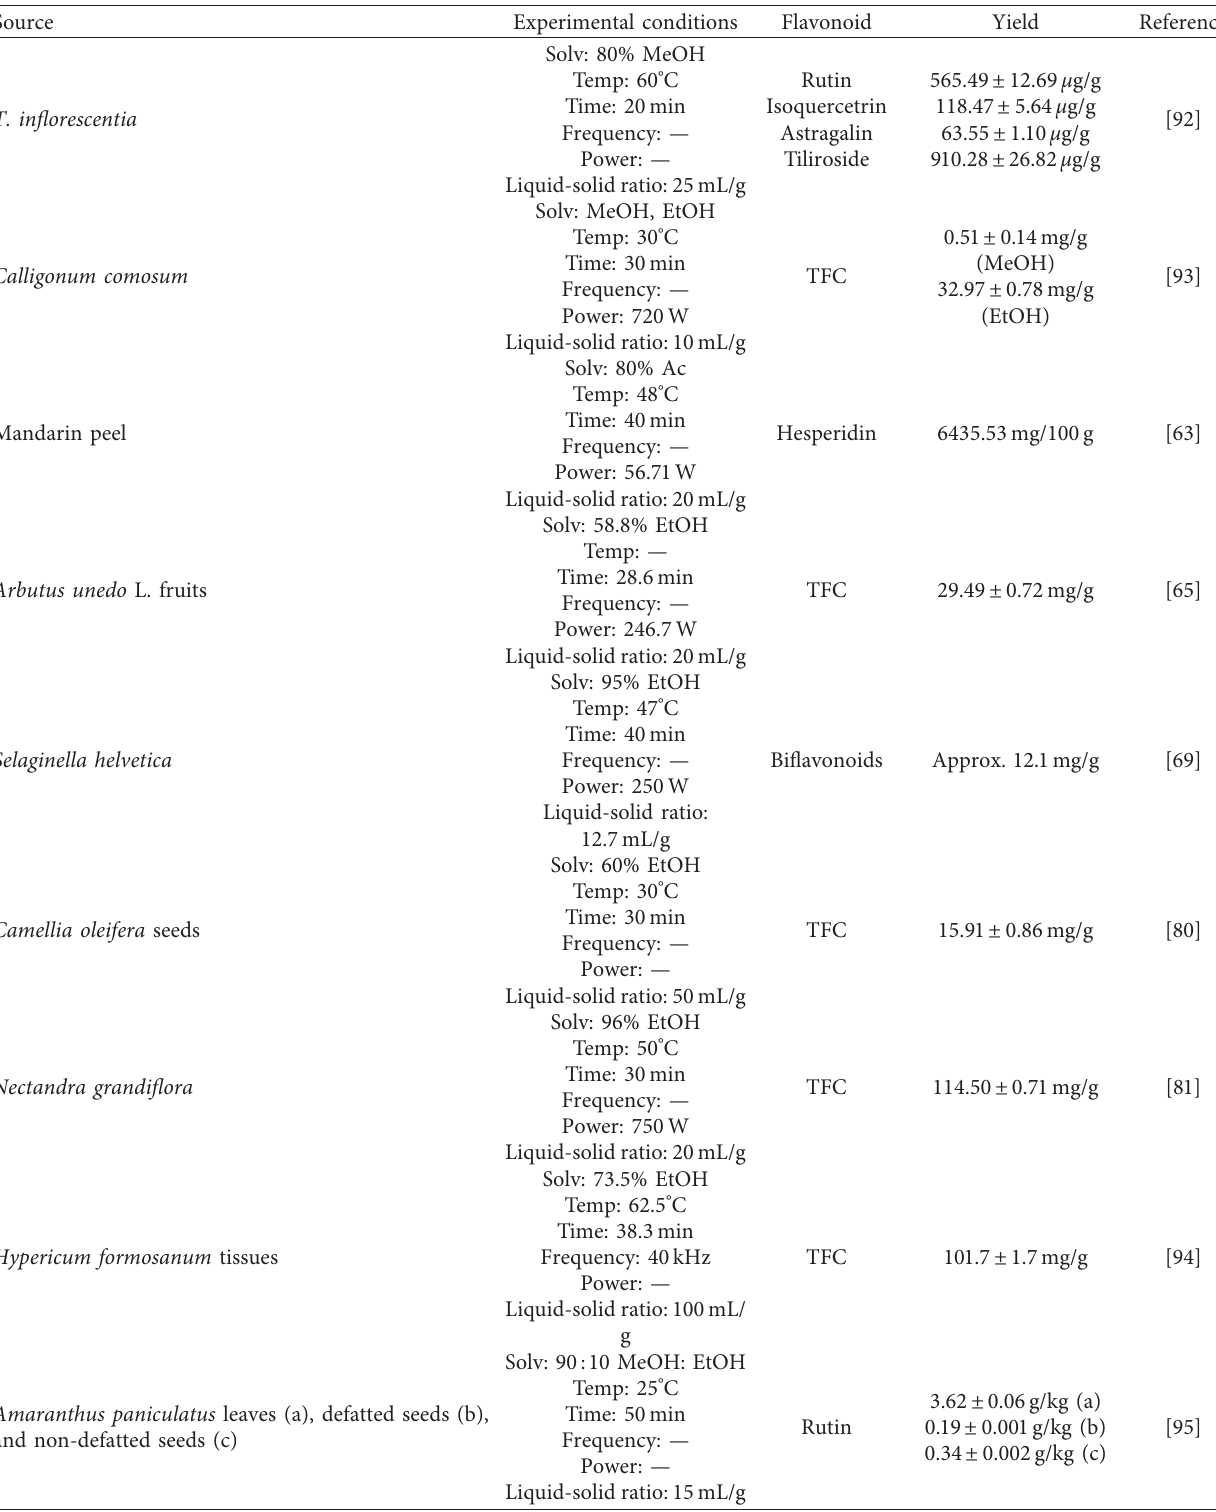
Table 2: Conditions of the extraction of flavonoids by